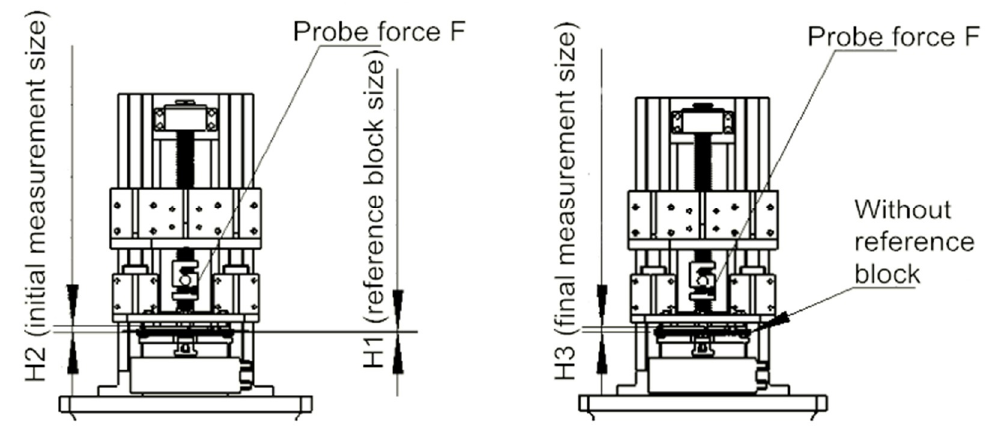
Figure 8. Synchronizer measurement steps.